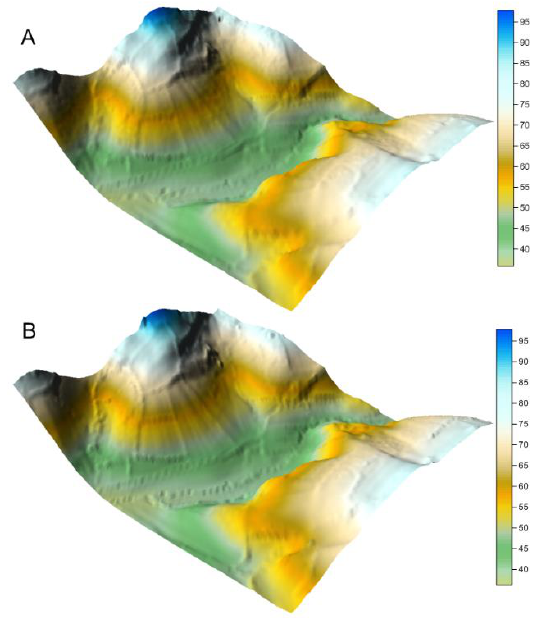
Figure 7. 3D representing of TIN Model (A) and reference DEM (B) for F21 site.